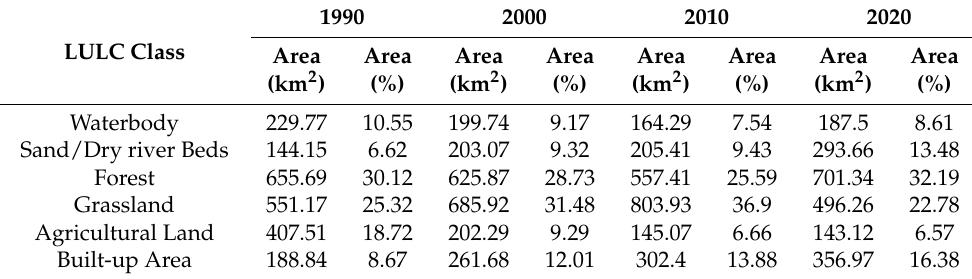
Table 3. Period-wise transformations of LULC class in the Kaziranga Eco-Sensitive Zone.